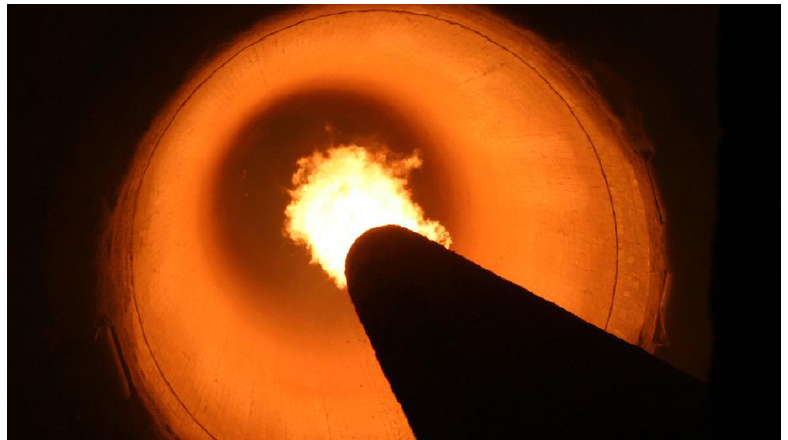
Figure 18. Investigation of the initial length of the torch in various modes (according to the authors’ data).